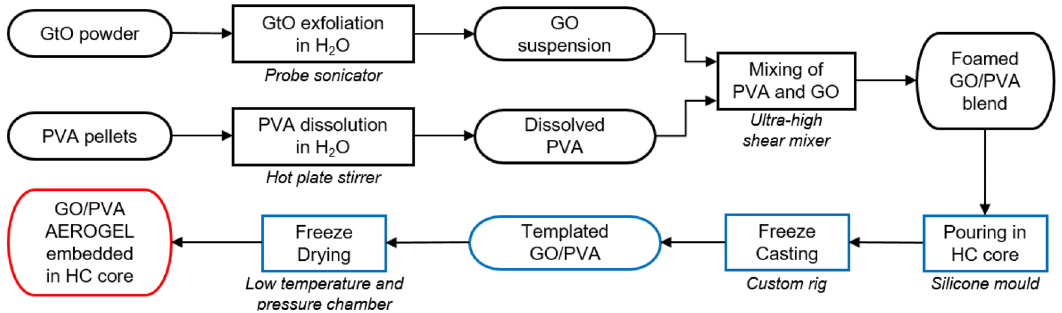
Figure 7. Diagram of ultralight GO/PVA aerogel fabrication